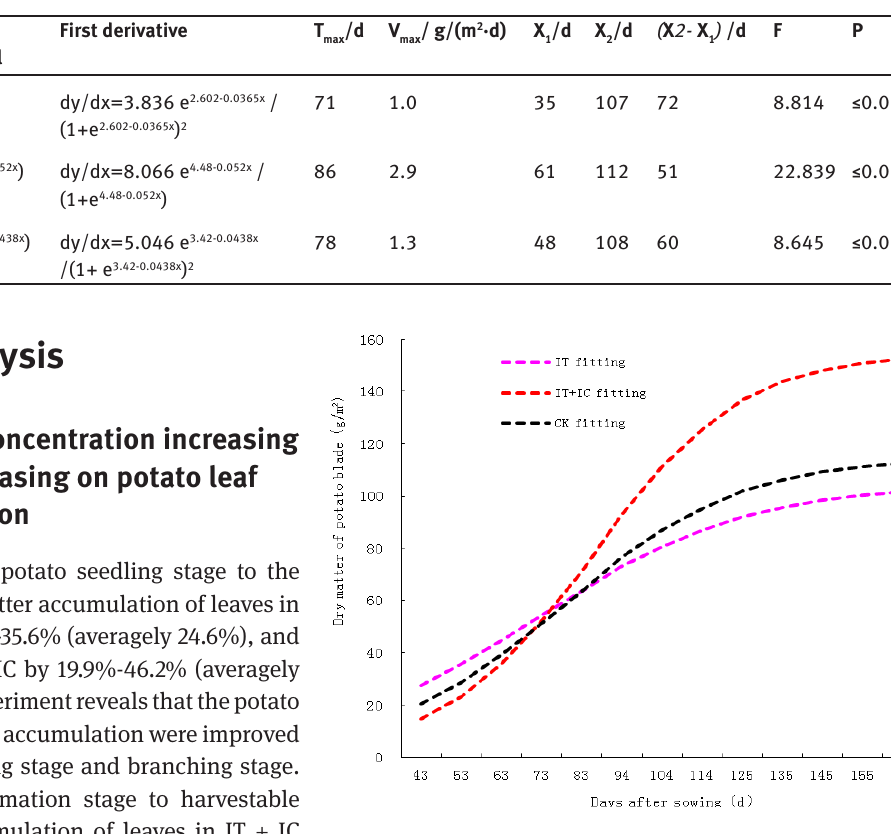
Figure1: Dynamic simulation curve of dry matter accumulation for potato leaves in different treatments.